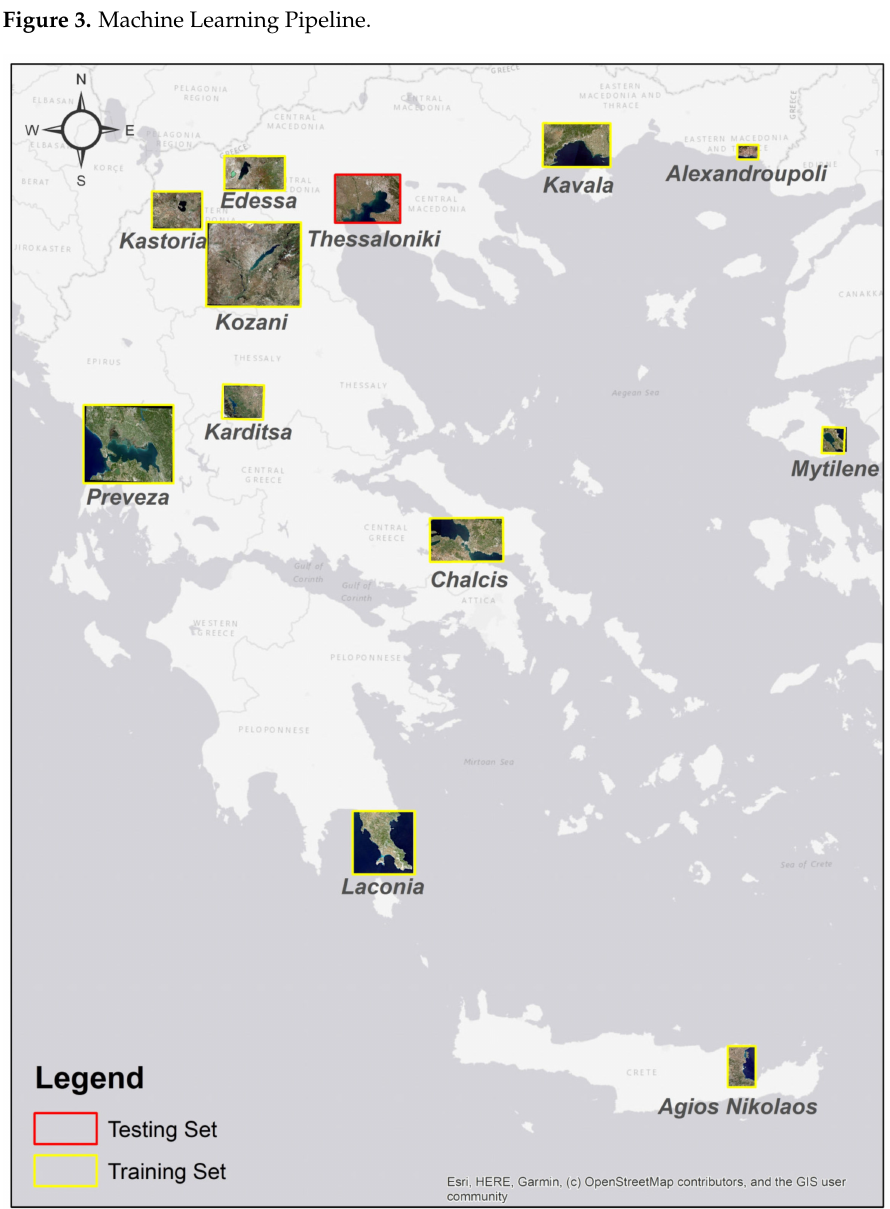
Figure 4. Areas selected for the Training and Testing Sets (best viewed in